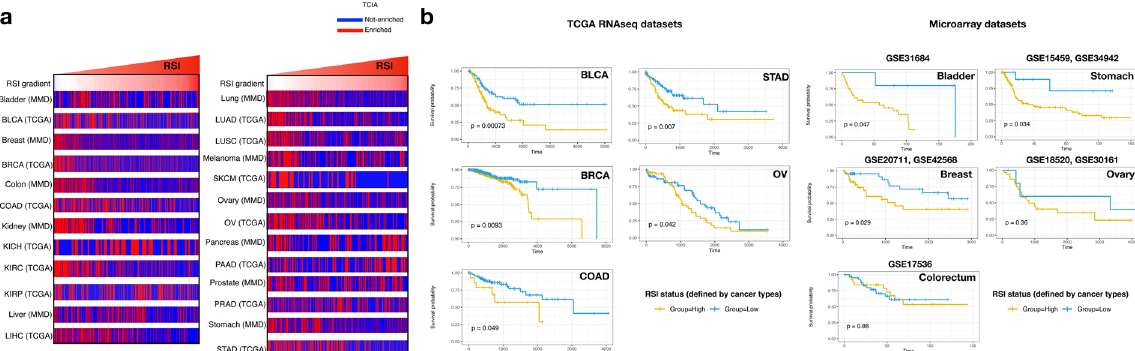
Fig. 4 Enrichment of TCIA and survival analysis. a Heatmap depicting enrichment status of the TCIA de fi ned by the mean z-transformed GSVA scores > 0.32 in the 11 cancer types. Columns have been ordered by increasing the RSI. b KM plots for the OS in patients with cancer of the bladder, breast, colon, ovary, and stomach with enriched TCIA. The RSI-High and RSI-Low tumours have been strati fi ed by the optimal cut- off value for OS in each cancer